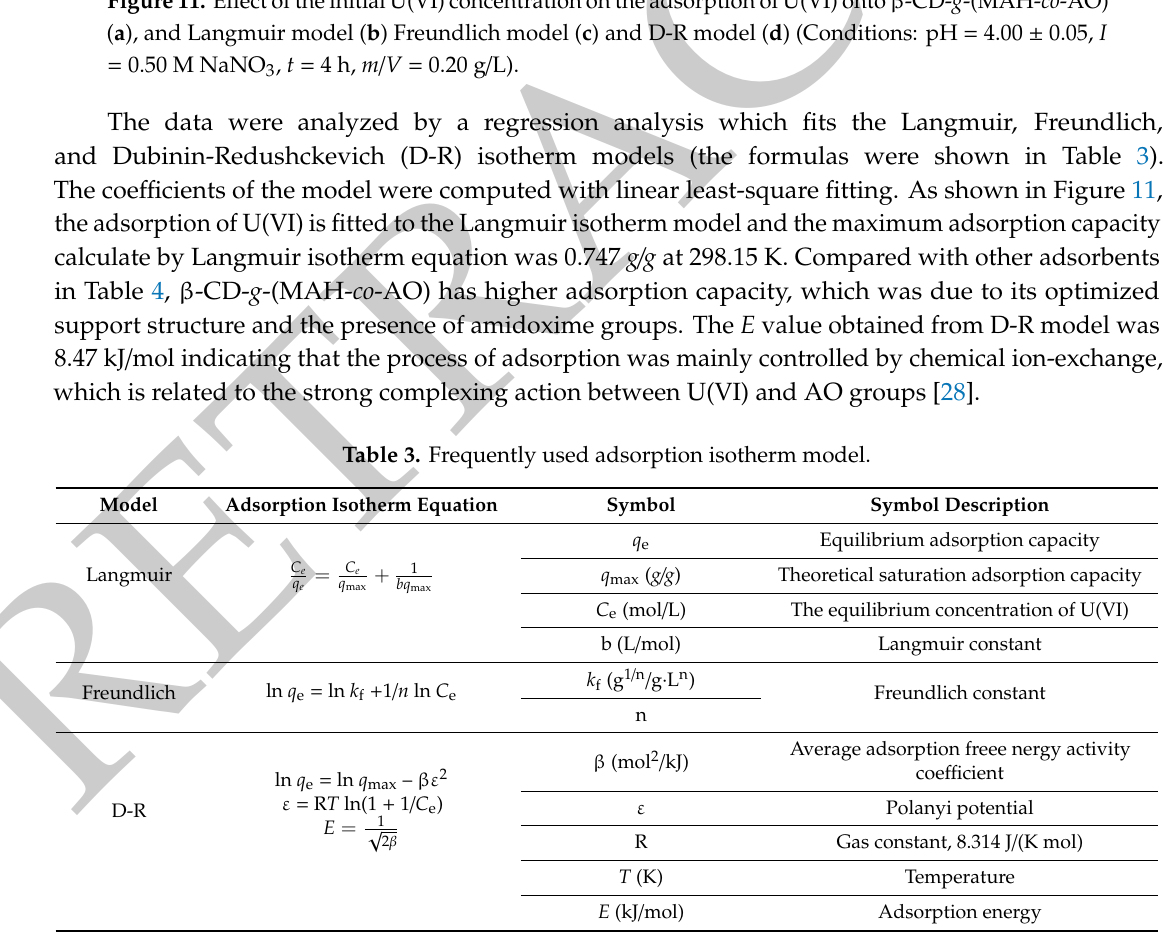
Table 4. Compared of uranium adsorption by amidoxime-functionalized materials.